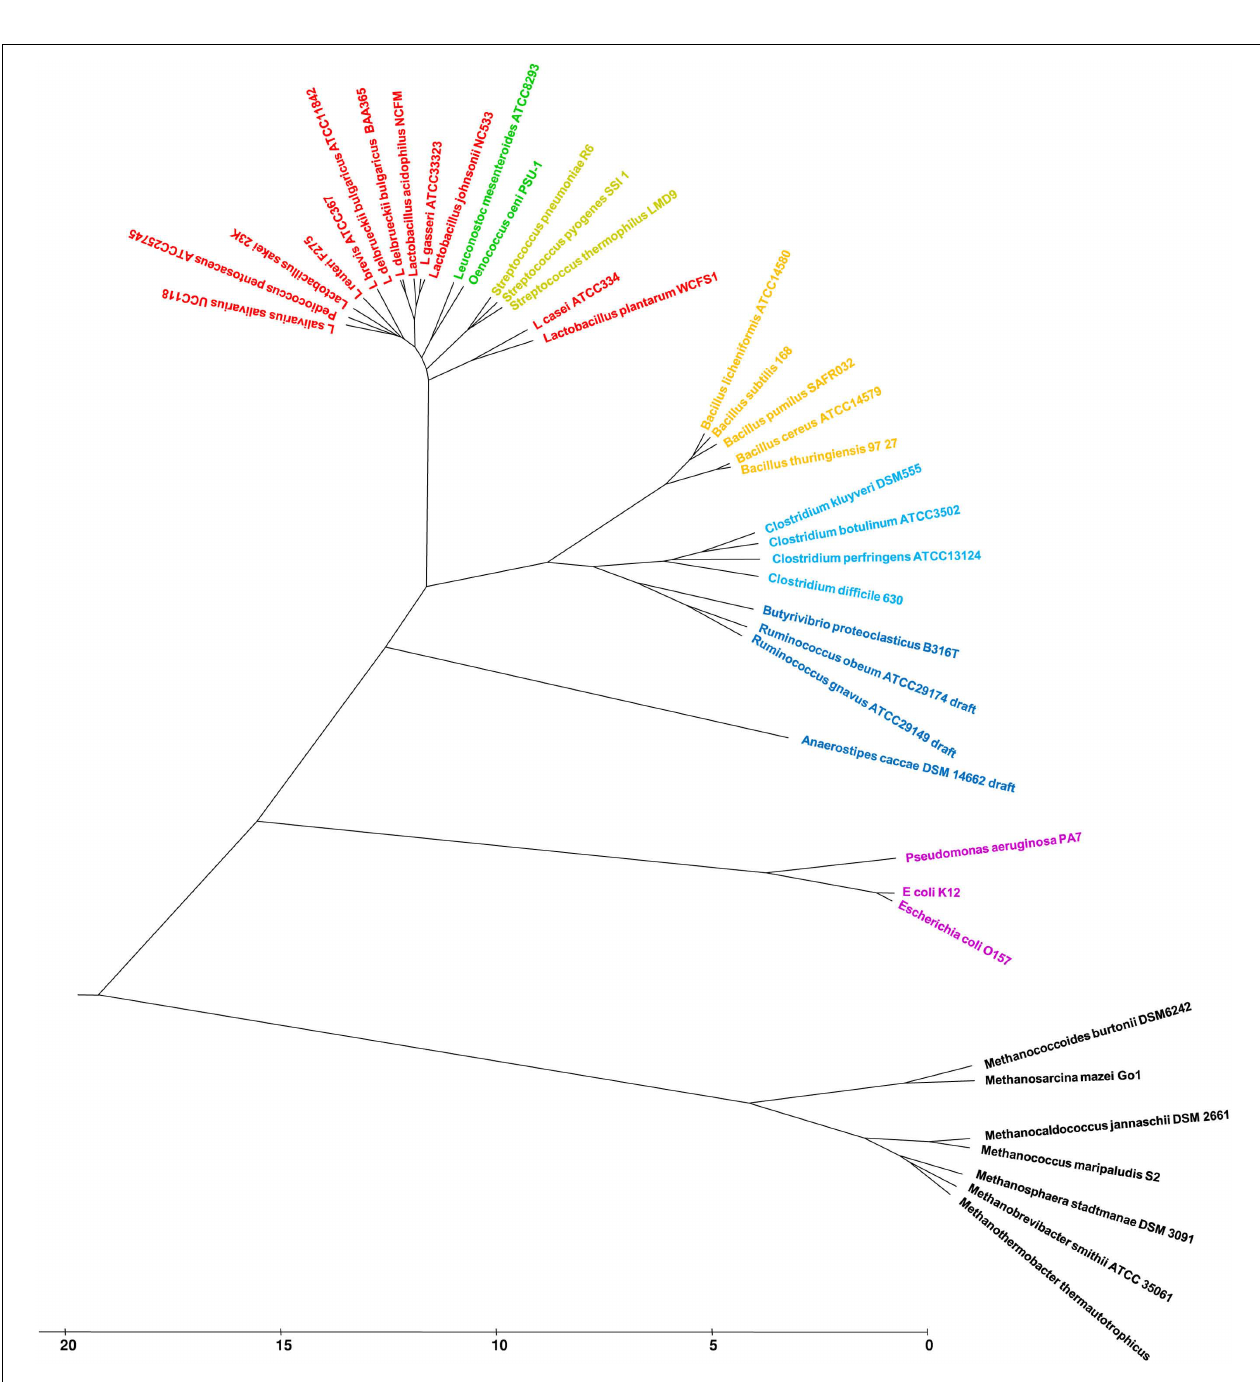
(publication in preparation). Predicted ORFeomes of all genomes were subjected to an FGD analysis and the resulting distance matrix was imported into MEGA4.The functional distribution was visualized using the UPGMA method (Sneath and Sokal, 1962).The optimal tree with the sum of branch length = 133.1 is shown.The tree is drawn to scale, with branch lengths in the same units as those of the functional distances used to infer the distribution